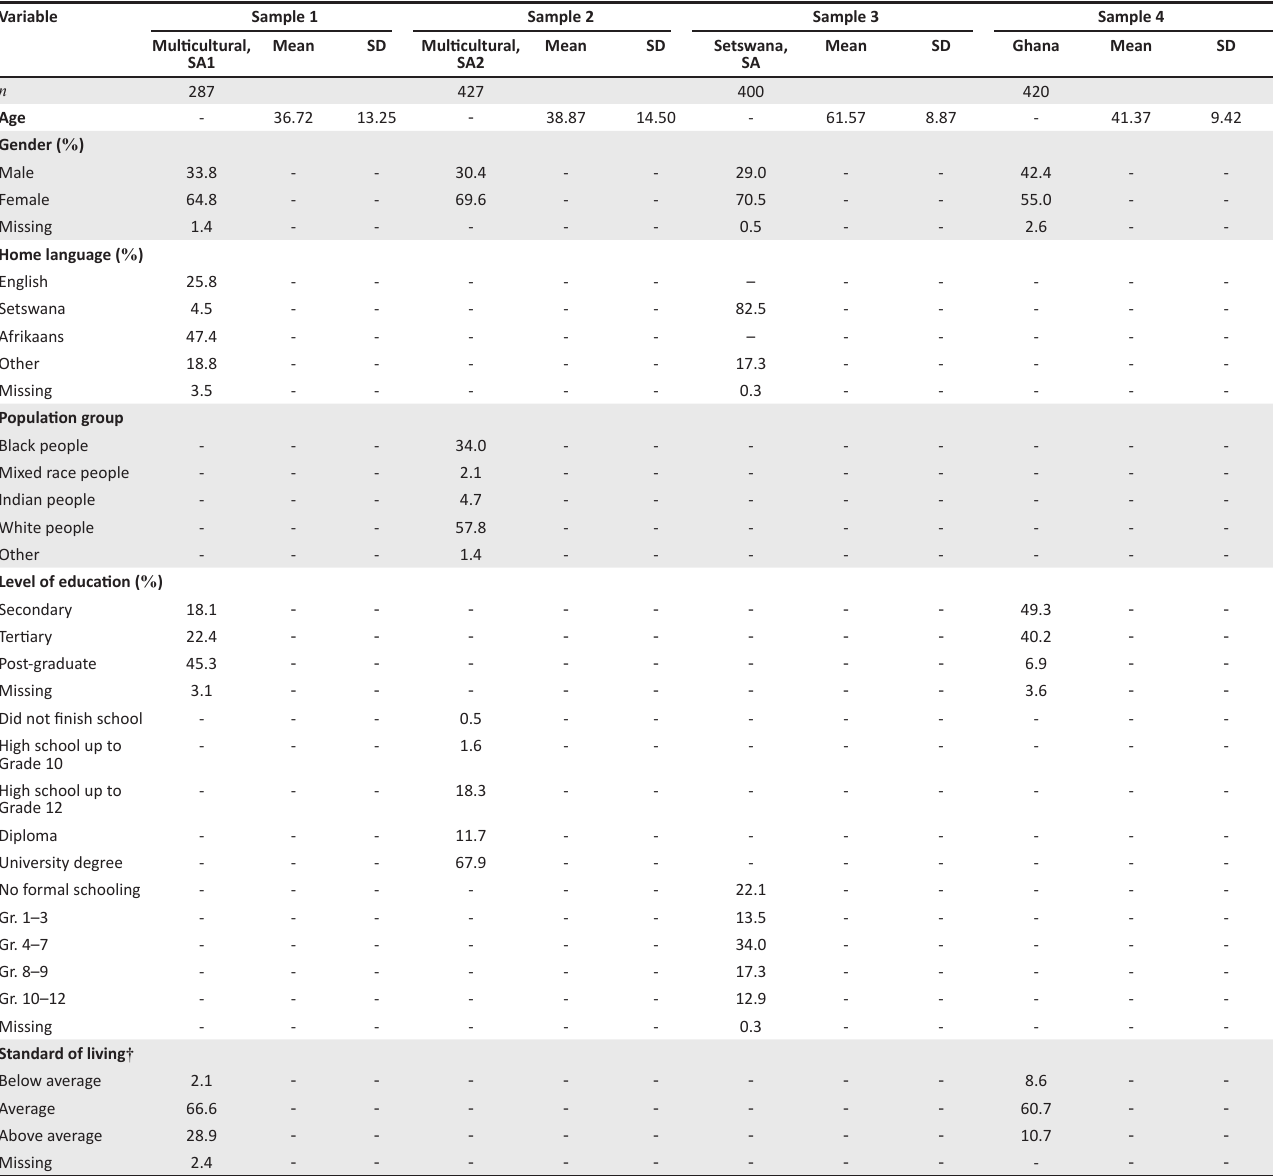
TABLE 1: Description of Samples 1 to 4. Variable Sample